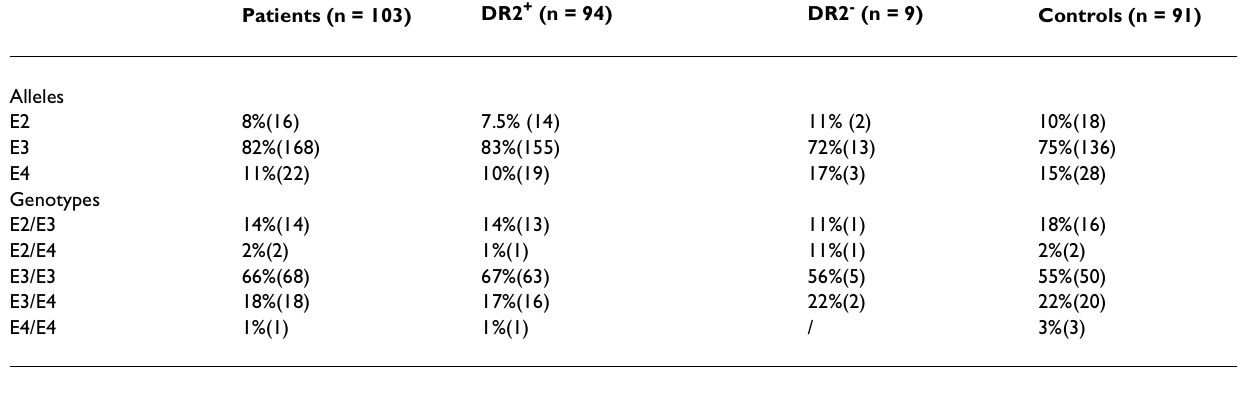
Table 1: Allele and genotype frequencies of the ApoE gene in narcolespy patients and controls. Patients (n =